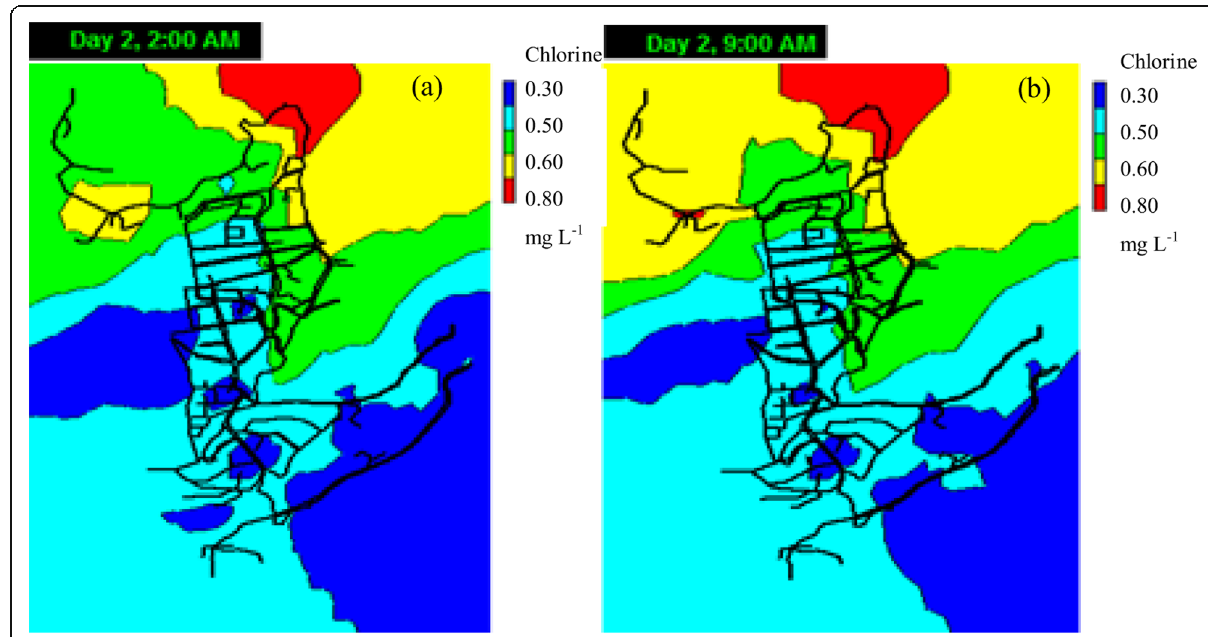
Fig. 9 Simulation of residual chlorine concentration, using an initial concentration of 0.8 mg L − 1 , which is the average value measured in the distribution tank. a At 2 am, residual chlorine concentrations in the 4% of the nodes are below 0.3 mg L − 1 . b At 9 am, chlorine concentrations in 2.5% of the nodes are below regulation (0.3 mg L − 1